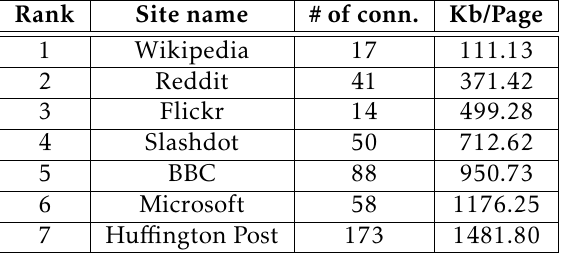
Table 1. Number of TCP connections per site when using standard HTTP. Ranking is performed according to Kb per page on the wire and to label sites in the rest of the paper.